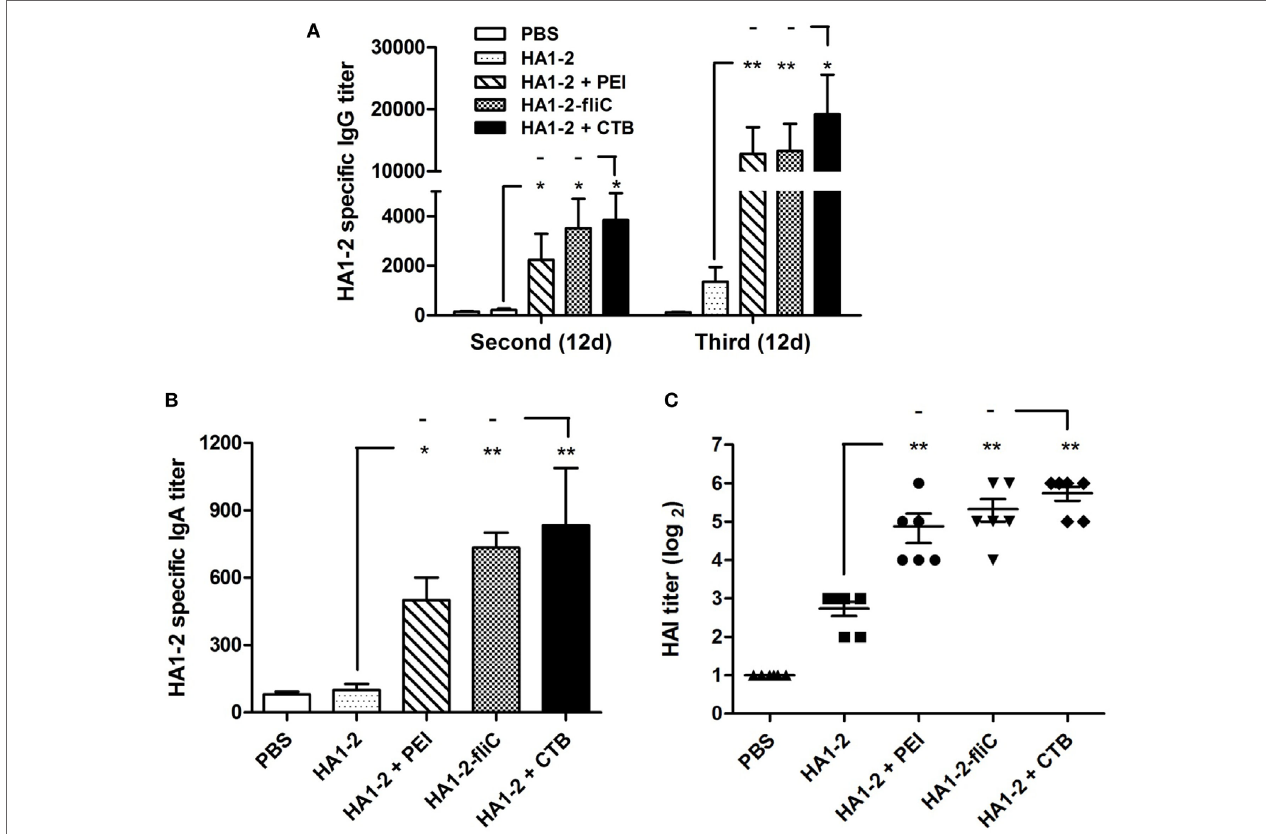
FigUre 2 | antibody response in serum . C3H/HeJ mice ( n = 6 per group) were vaccinated intranasally with three doses of HA1–2, HA1–2-fliC, PBS, or HA1–2 combined with PEI or CTB. Animals were bled 12 days after the second and third immunizations. Antibody titers were measured by ELISA or hemagglutination inhibition (HAI) assay. (a) HA1–2-specific IgG titers after the second and third immunizations. (B) HA1–2-specific IgA titers after the third immunizations. (c) HAI titers after the third